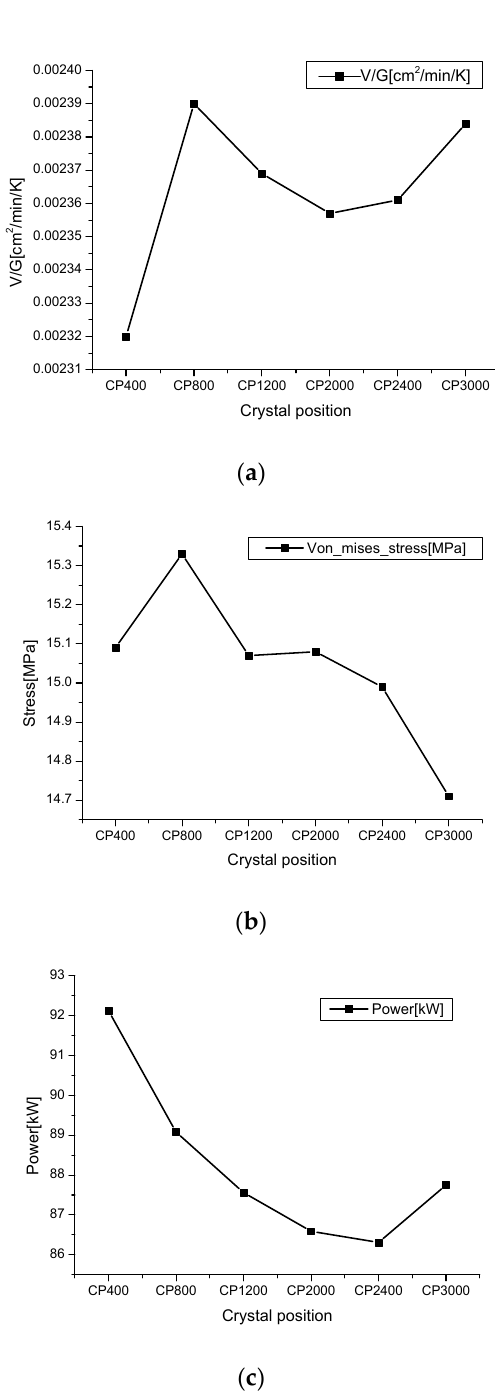
Figure 3. CG-Sim analysis for single-crystal Si ingot at a pulling rate of 1.0 (mm / min) with various CP heights: ( a ) V / G (ratio of the growth rate to the vertical T gradient), ( b ) von Mises stress, and ( c ) power by CP (crystal position).